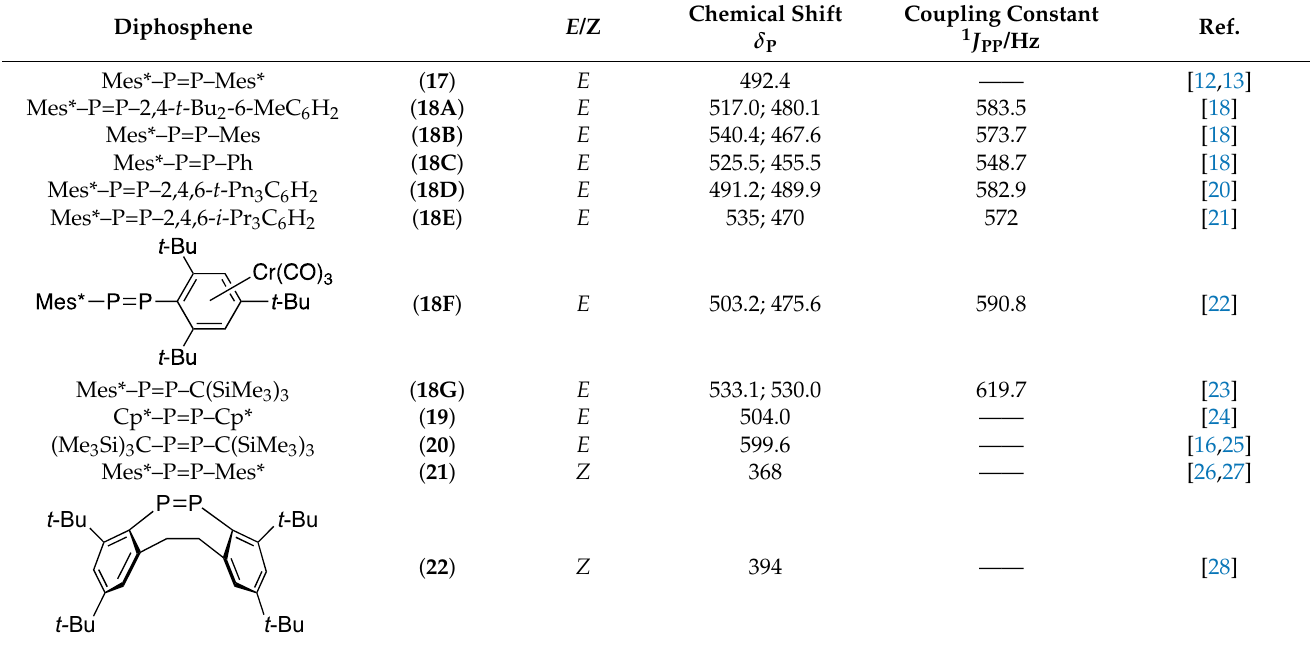
Table 2. 31 P NMR data for some diphosphenes.